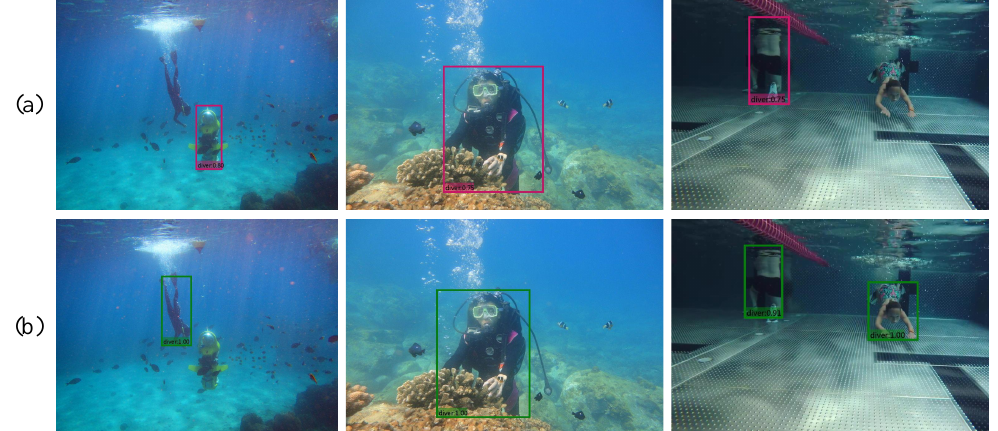
Figure 10. Comparison of test results between air dataset and diver dataset. ( a ) The results of the model trained by the air dataset. ( b ) The results of the model trained by the Diver dataset.